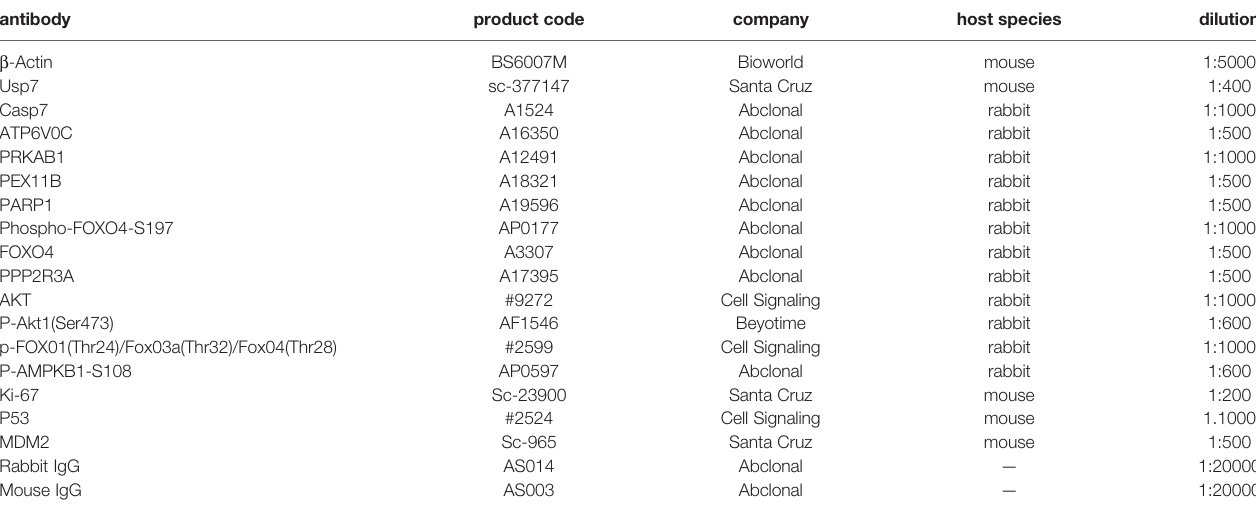
TABLE 1 | List of All Antibodies and Sources.